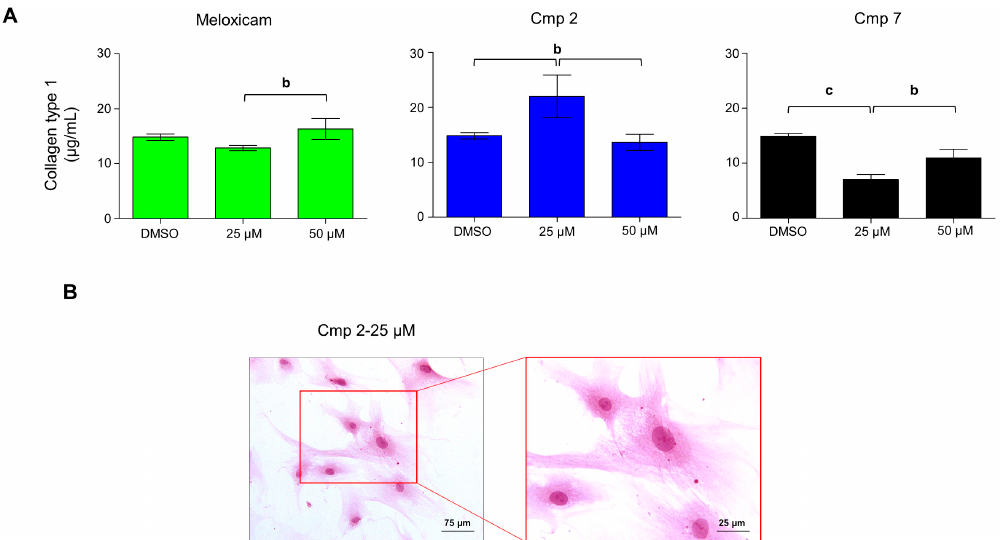
Figure 6. Collagen type I secretion from tendon-derived cells pre-incubated with hydrogen peroxide (H 2 O 2 ) in the presence of Meloxicam and Cmp 2 and Cmp 7 . Data are reported as means ± standard deviations of independent experiments with the three donors pooled (n = 9). ( A ) Bar graphs show collagen type I concentration obtained by ELISA assay in cell supernatants ( µ g/mL) of tenocytes pre-incubated with H 2 O 2 100 µ M for 3 h and afterwards exposed to Meloxicam, Cmp 2 , and Cmp 7 at 25 and 50 µ M for 72 h. Values are normalized on MTT data from the same experiment. DMSO = cultures pre-incubated with H 2 O 2 and treated with DMSO 0.2% (vehicle). b = p < 0.001 and c = p < 0.0001 between samples and DMSO alone. ( B ) Hematoxylin/eosin staining of tenocytes pre-incubated with 100 µ M H 2 O 2 for 3 h and exposed to Cmp 2 at 25 µ M for 72 h. Magnification 200 × and 400 × . Bar scale represents 1 cm = 75 and 25 µ m, respectively.